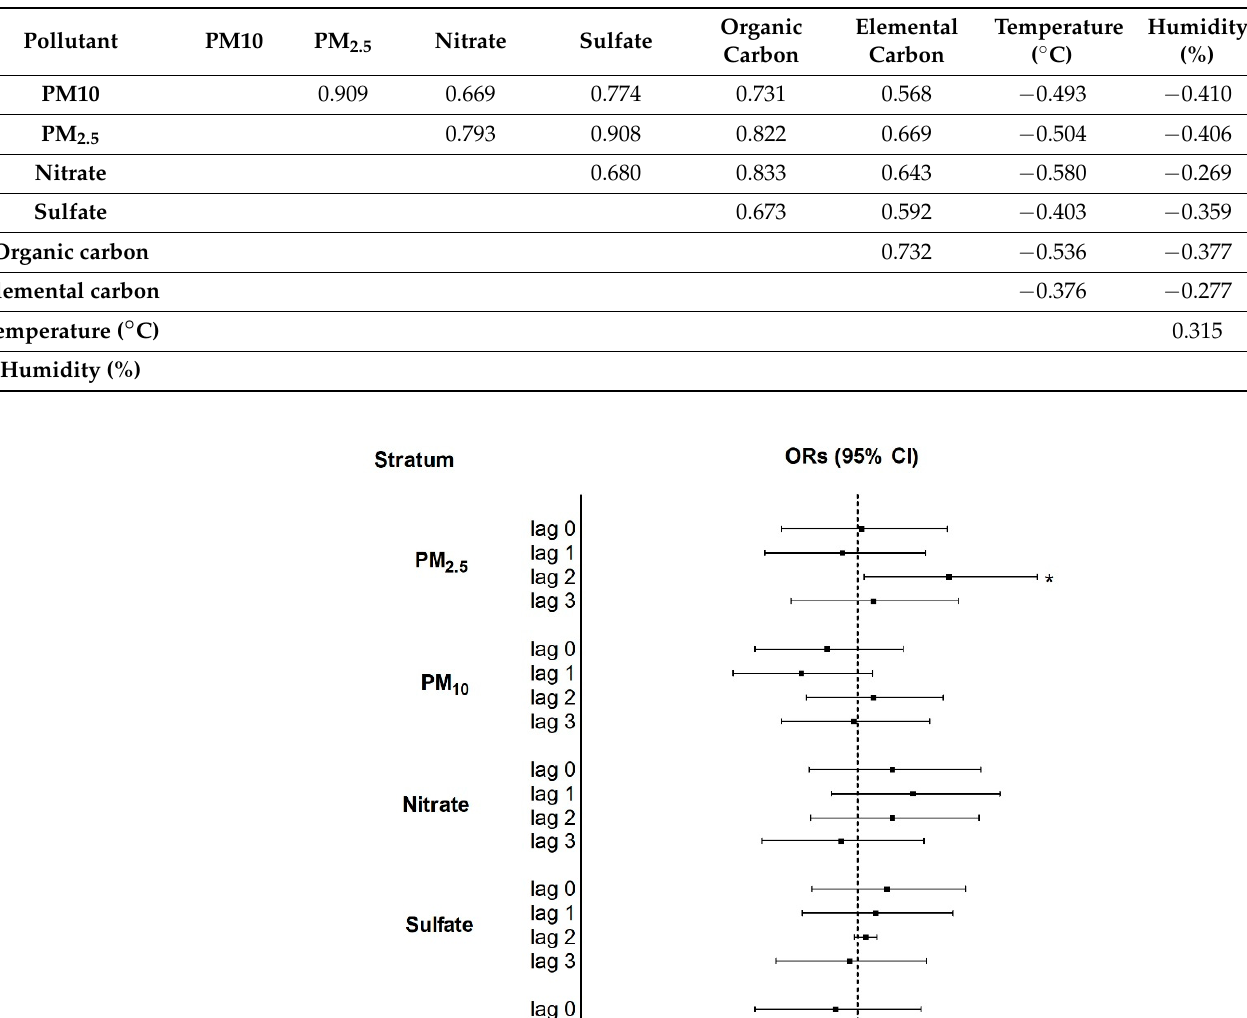
Table 3. Pearson correlation coefficients between air pollutants and weather conditions in the study period.